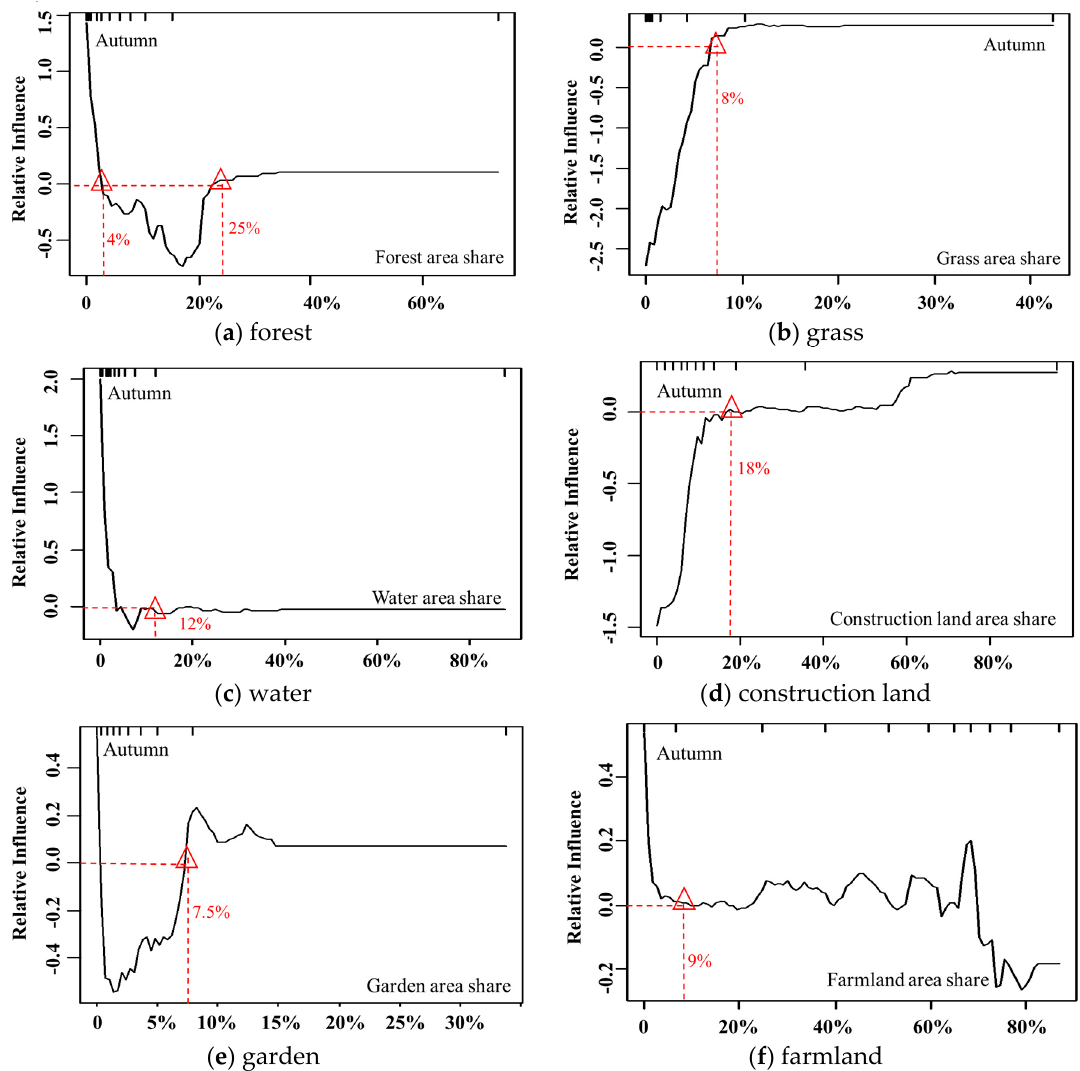
Figure 10. The influence of the main factors (concentration rate >10%) on PM 2.5 in autumn.